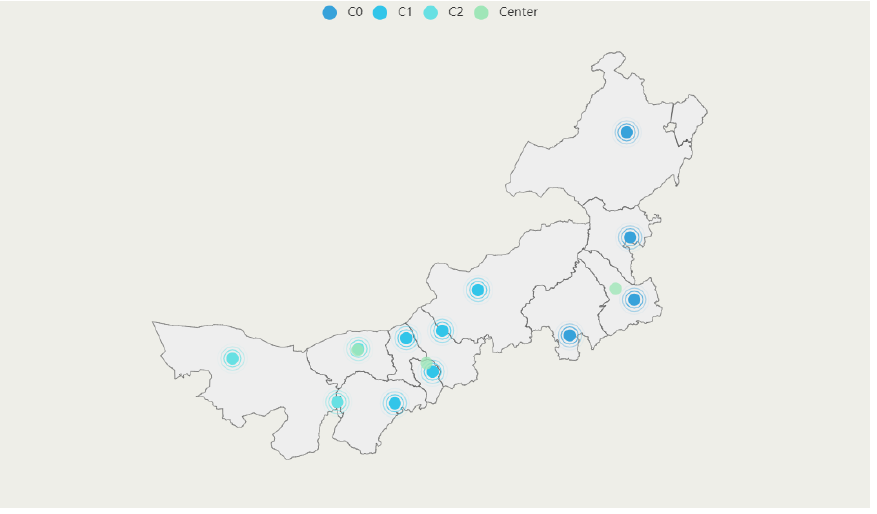
Figure 4. The location results for the 2SM.